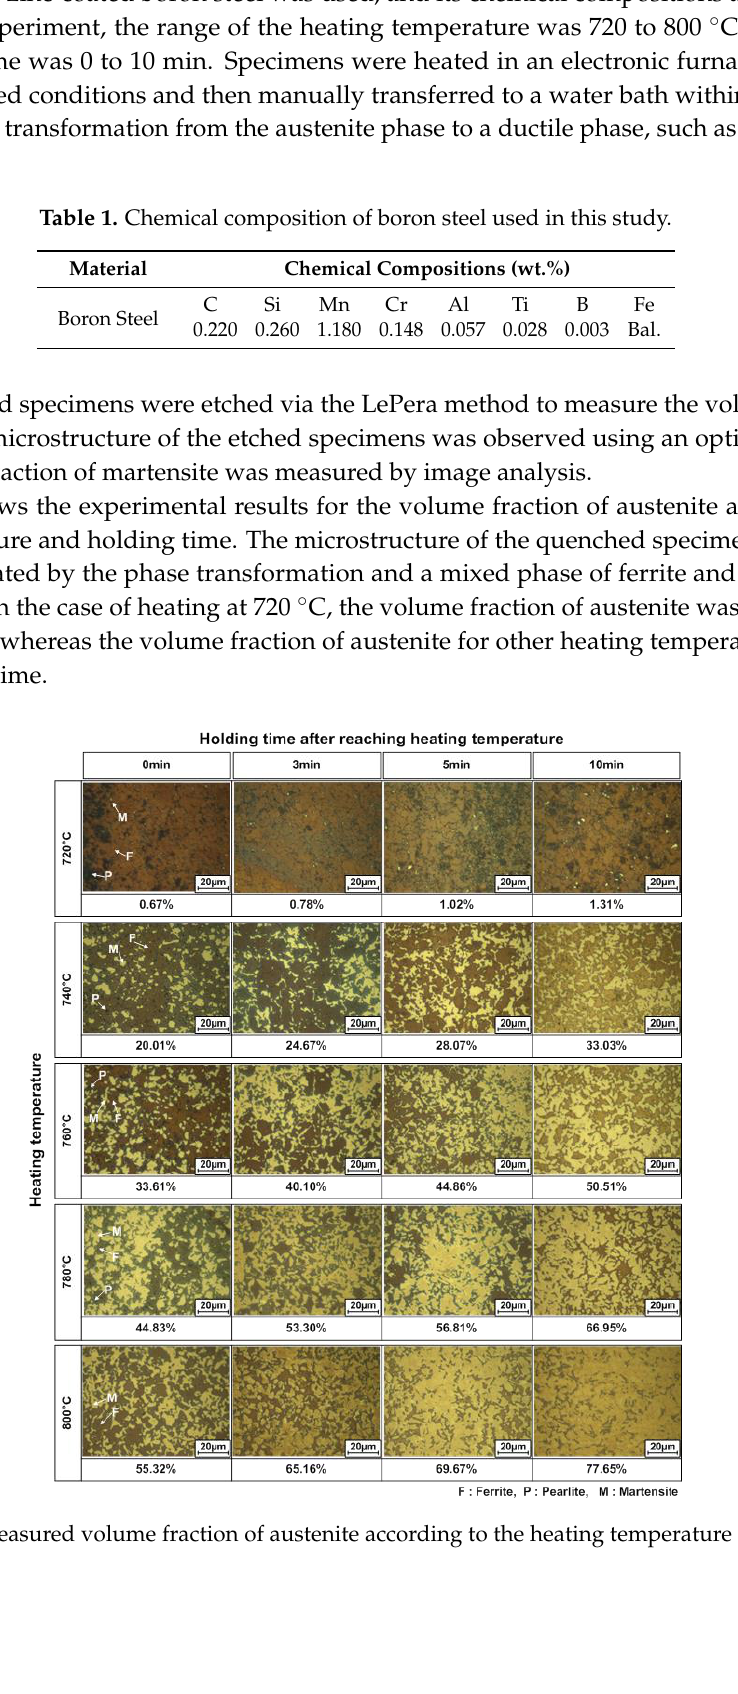
Table 2. Material constants of boron steel in the Johnson – Mehl – Avrami – Kolmogorov (JMAK) equation.